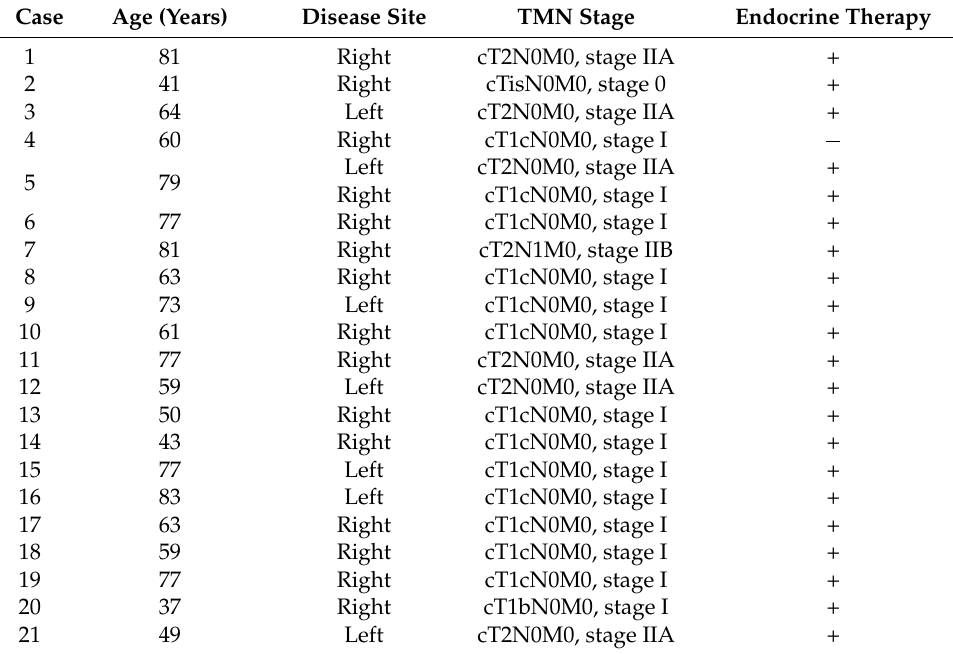
Table 1. Profiles of all patients.